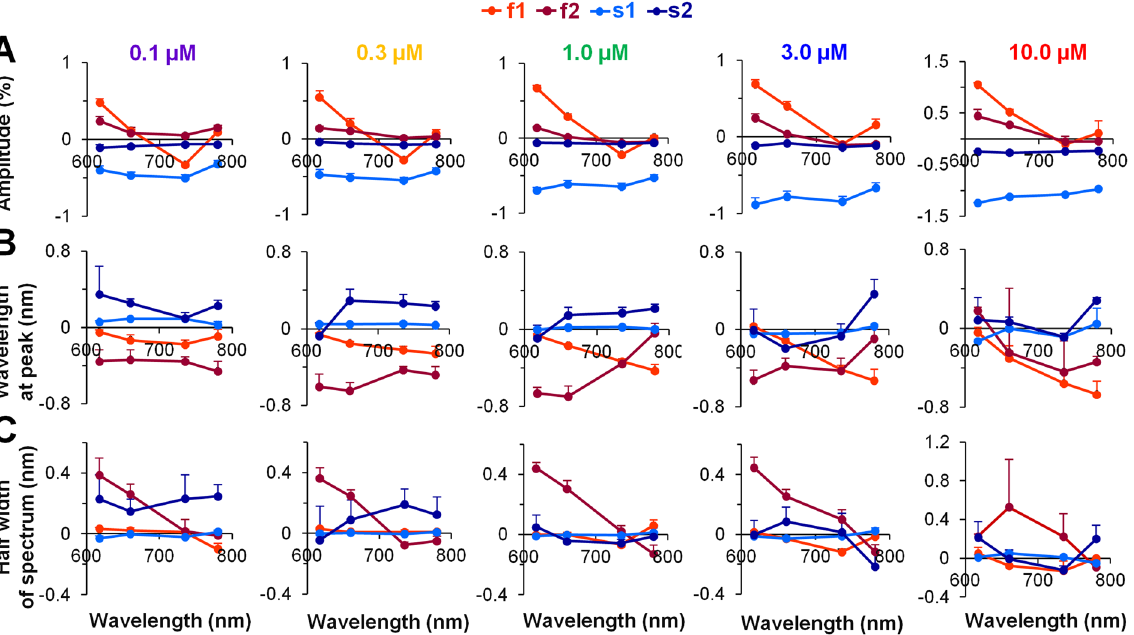
Figure 5. Mean changes in the Gaussian parameters induced by depolarization for each of the four constituents at various concentrations of the ICG dye. The parameters of the fluorescence signals recorded during excitation at wavelengths of 617 nm, 660 nm, 735 nm, and 780 nm are presented as points. ( A – C ) Each of the four Gaussian constituents (two for the OS f component (f1 and f2; red and dark red , respectively) and two for the OS s component (s1 and s2; blue and dark blue , respectively) has three parameters: the amplitude, the wavelength at fluorescence maximum (i.e., at the peak of the spectrum), and the half width of the spectrum at 50% of the fluorescence maximum. Note: these parameters were determined at five different concentrations of the ICG dye ranging from 0.1 to 10.0 µ M (n = 3–9 for each). Error bars indicate